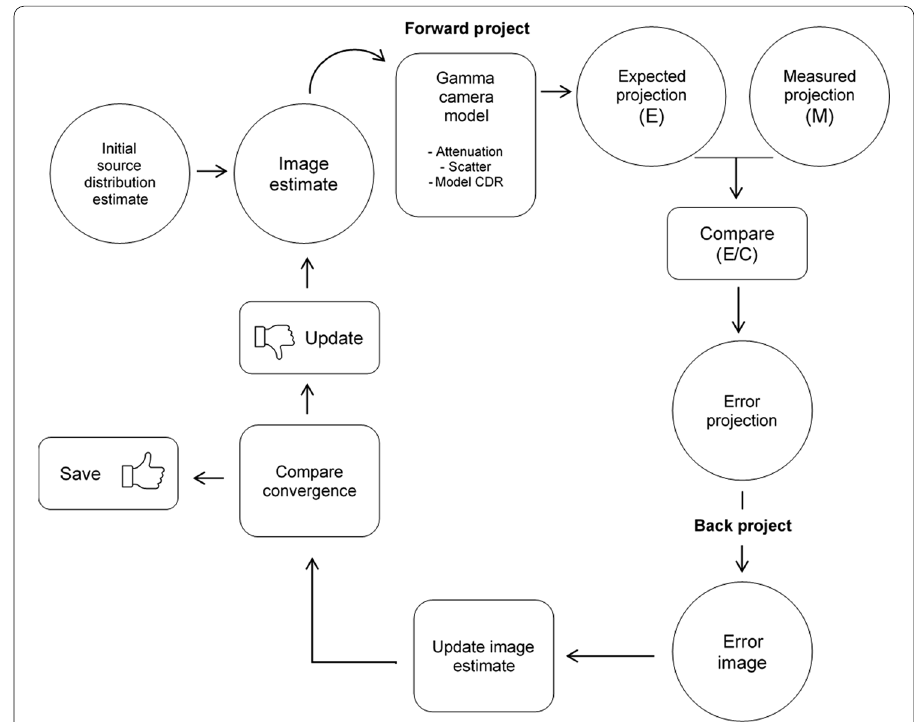
Fig. 1 Schematic describing basic steps of iterative reconstruction